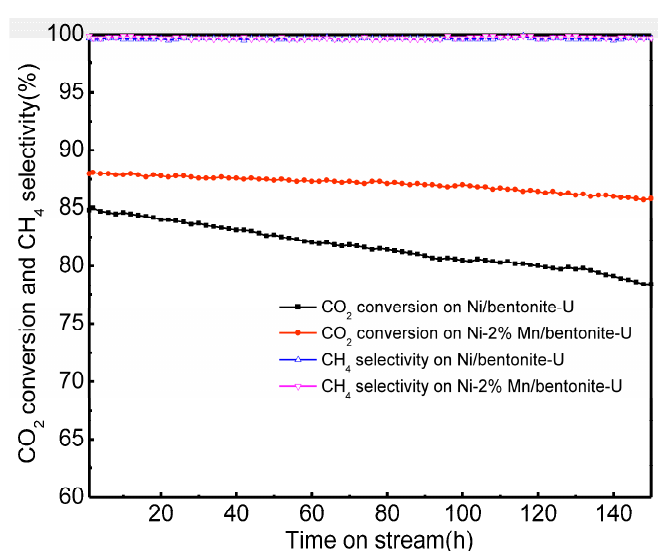
Figure 9. Stability performance of Ni/bentonite and Ni-2wt%Mn/bentonite catalysts. Reaction conditions: atmospheric pressure, T = 300 °C, V (H 2 )/ V (CO 2 ) = 4, GHSV = 3600 mL·g cat − 1 ·h − 1.